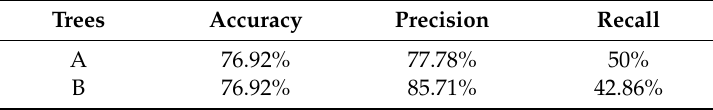
Table 2. Statistical evaluation of decision tree models.